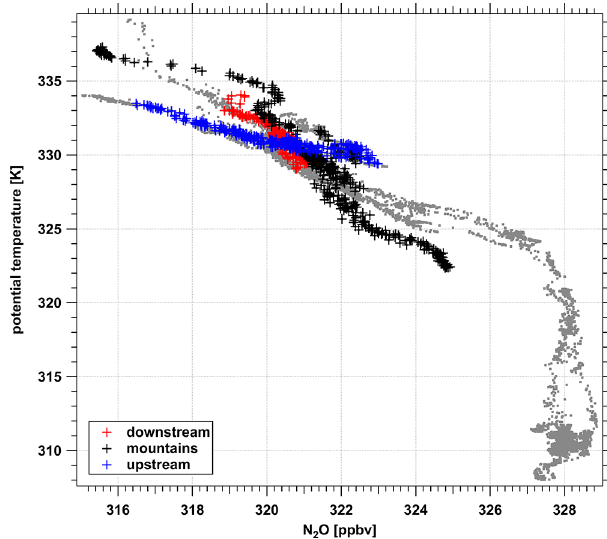
Figure 8. Profile of N 2 O during FF09 (gray) as a function of poten- tial temperature (cid:50) . The upper leg of the southwestern part is shown with different colors, indicating different flight sections along the flight leg (blue: upstream, red: downstream, black: above the moun- tains, comp. Fig.